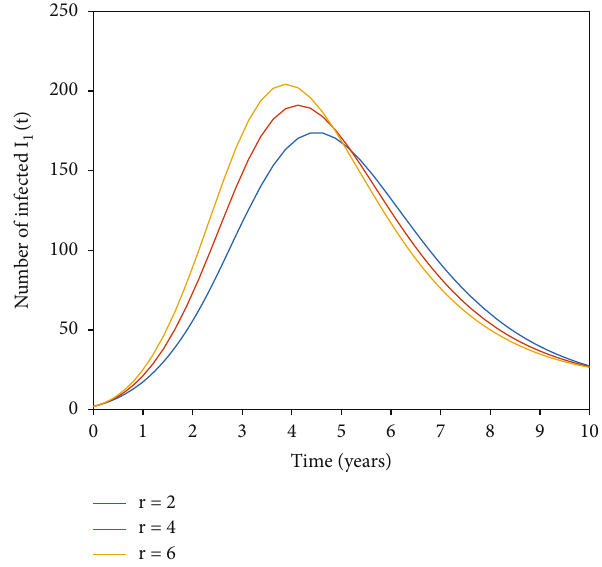
Figure 18: Transformation of infected individuals for constant injecting rate of UV index r with various